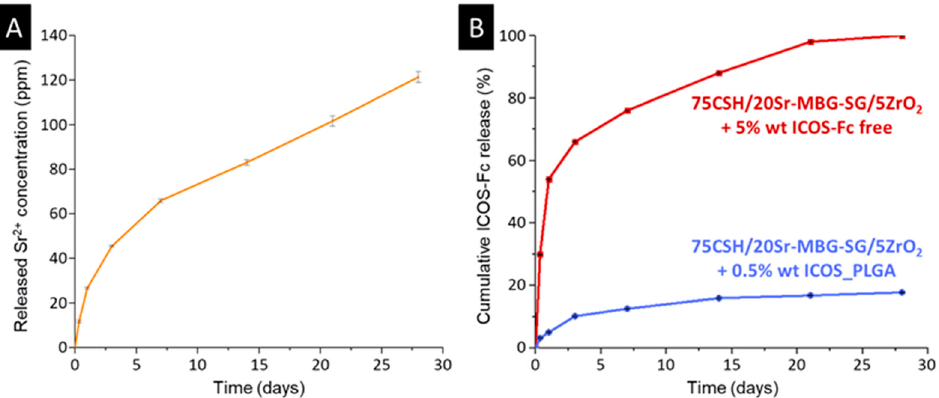
Figure 7. Strontium ion release kinetics from the optimized composite cement formulation ( A ) and ICOS-Fc release profile from the anti-osteoclastogenic cements ( B ) with free dispersed ICOS-Fc (red line) and the formulation containing ICOS_PLGA (blue